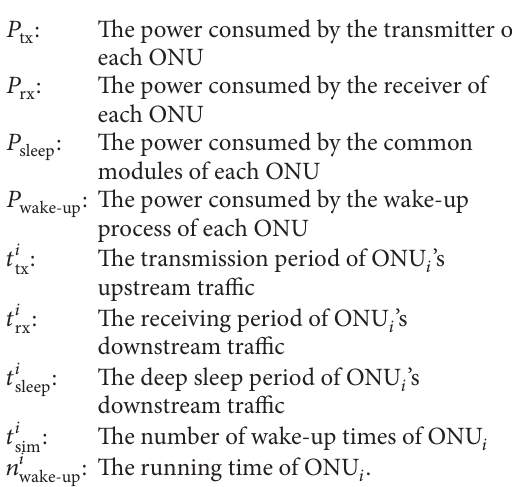
considered when designing the energy-saving algorithm. In addition, the ONU wake-up times were also considered. The simulation was run from three different perspectives, and it was demonstrated that our proposed ESMT is effective in terms of both energy consumption and packet